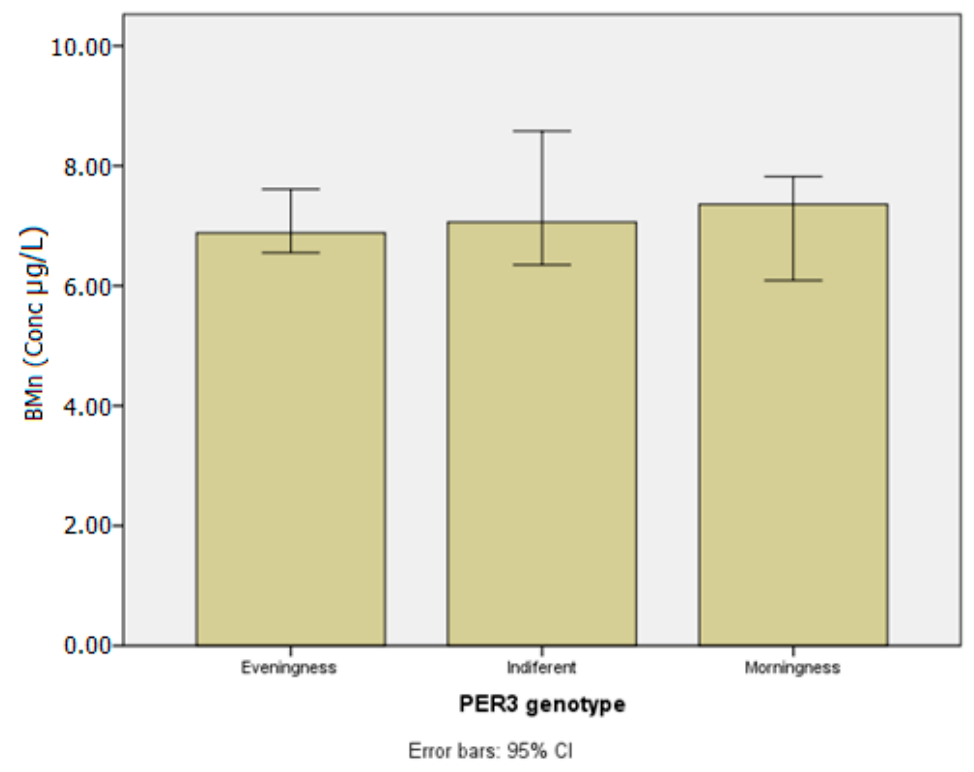
Figure 4. Manganese in blood ( µ g/L) according to PER3 gene VNTR polymorphisms.